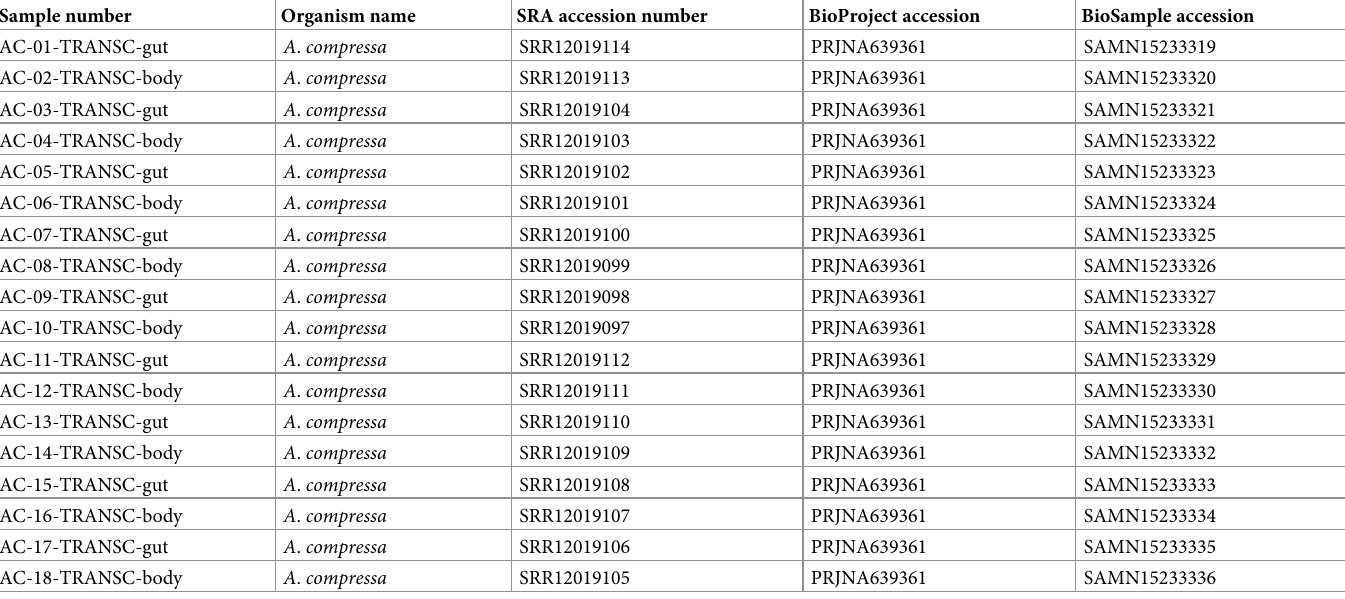
Table 1. NCBI accession numbers, BioProject and BioSample IDs of newly sequenced and analyzed transcriptomes of Ampulex compressa